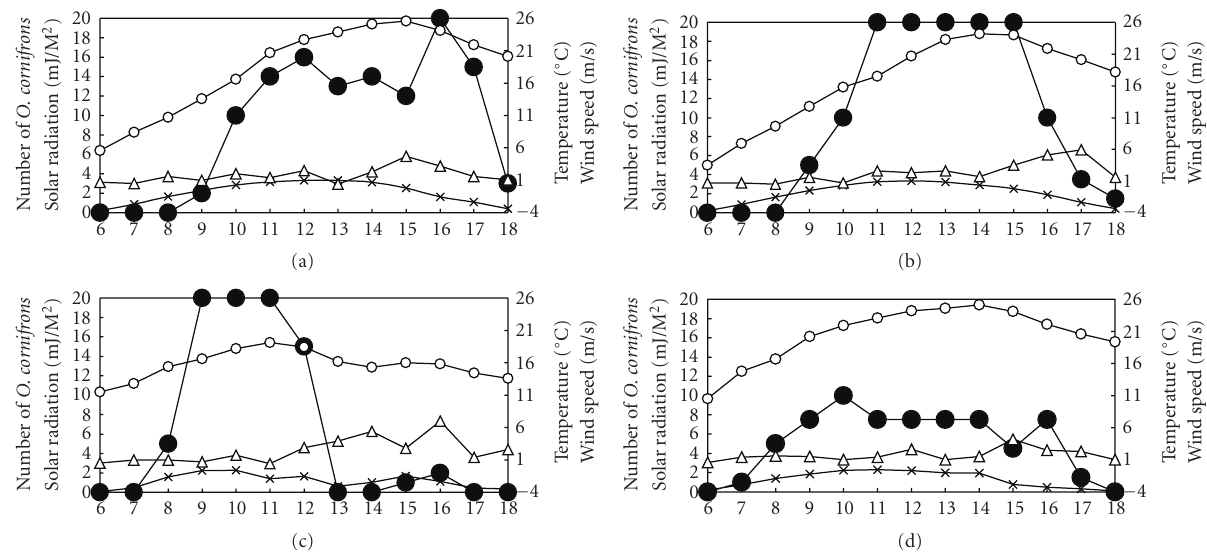
Figure 1: Activity of O. cornifrons (black circles) during 4 days at a nesting site in the Nagano orchard. Ambient temperature ( ◦ C, white circles), solar radiation (MJ/m 2 , cross), and wind speed (m/s, triangles) are also shown. (a) 30th of April, 2007, (b) 29th of April, 2008, (c) 2nd of May, 2007, and (d) 1st of May, 2008.